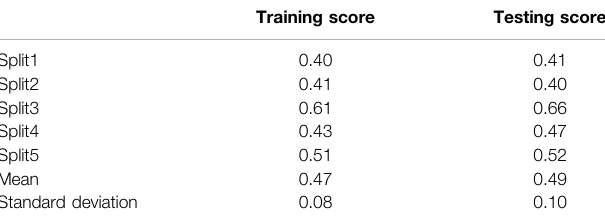
TABLE 4 | Training score and testing score of the Dataset 1 Training score